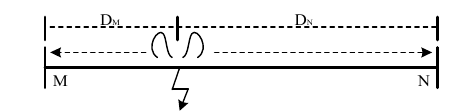
Figure 2. Principle of two-terminal fault location.